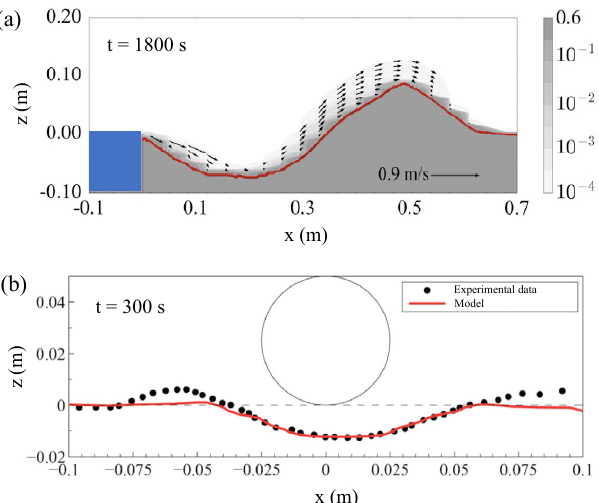
Figure 11. ( a ) Computed velocity field of the sediment phase at t = 1800 s (adapted from Lin et al. [104]); ( b ) Scour profile - comparison between the numerical model and the experimental data of Sumer and Fredsøe [118] (adapted from Ouda and Toorman [117]).